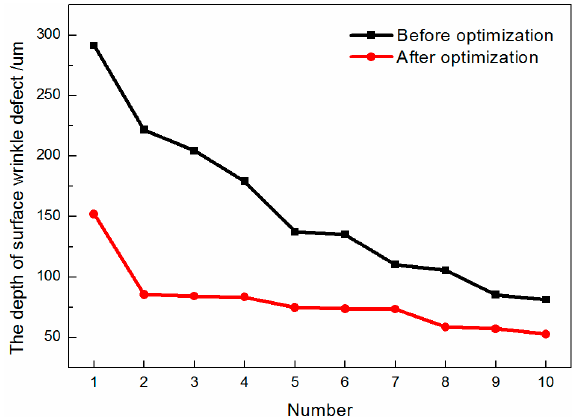
Figure 16. The depth measurement of surface wrinkle defects before and after optimization of process parameters.